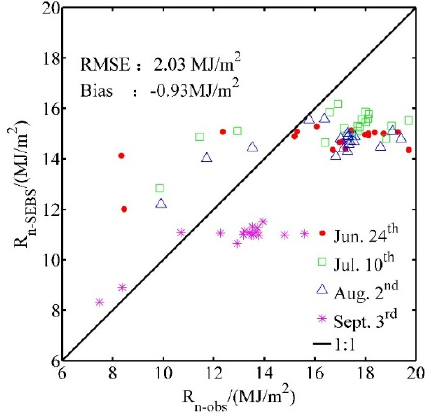
Figure 10. Comparison of modeled daily net radiation from SEBS and daily net radiation observed from the 16 AMSs on 24 June, 10 July, 2 August, and 3 September, 2012.